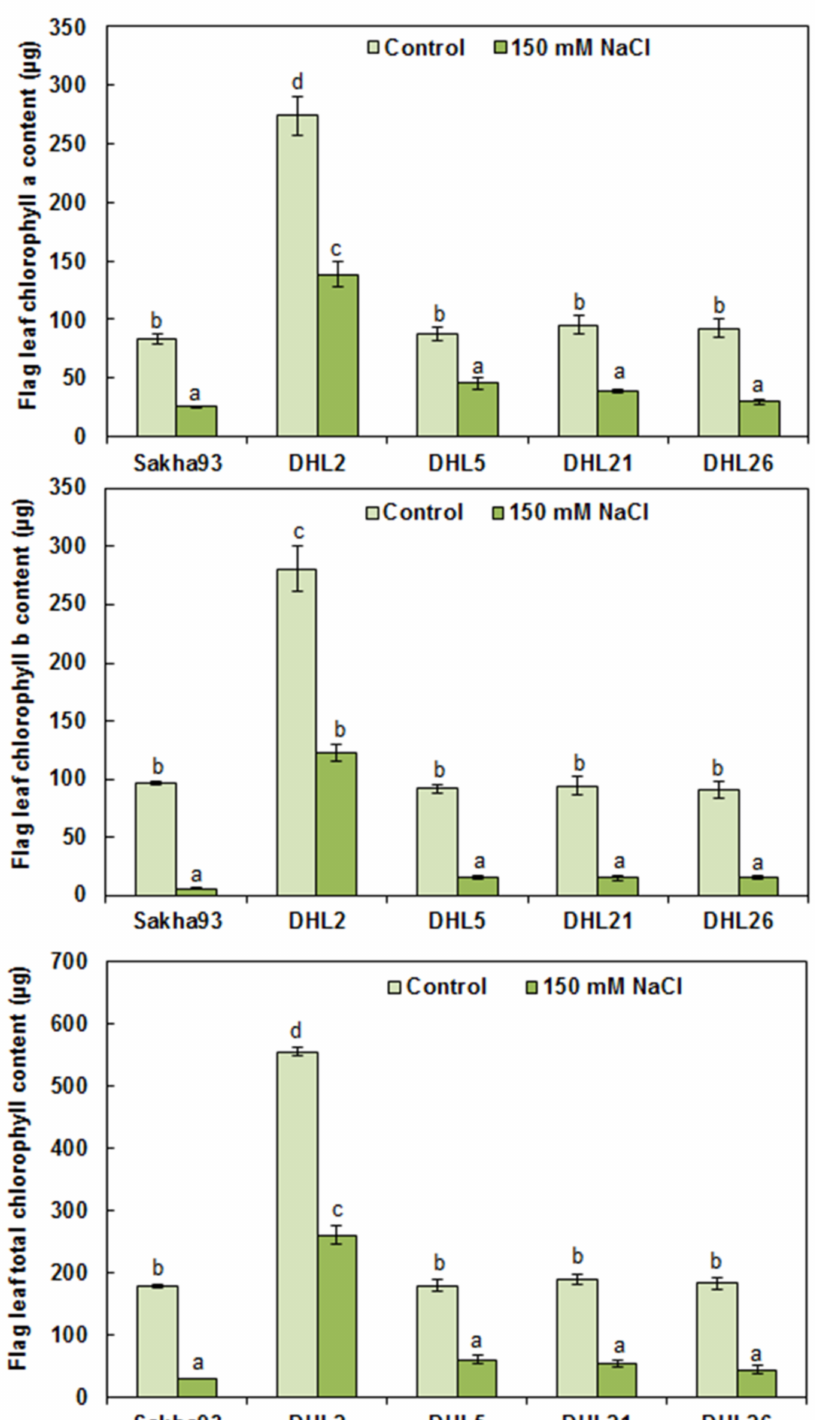
Figure 3. Chlorophyll a, chlorophyll b, and total chlorophyll content of flag leaves of wheat genotypes subjected to irrigation water with or without 150 mM NaCl. Values are presented as the mean ± SE of at least three replications, and values sharing the same letter for each treatment × genotype combination are not significantly different ( p ≤ 0.05) according to Duncan’s multiple range